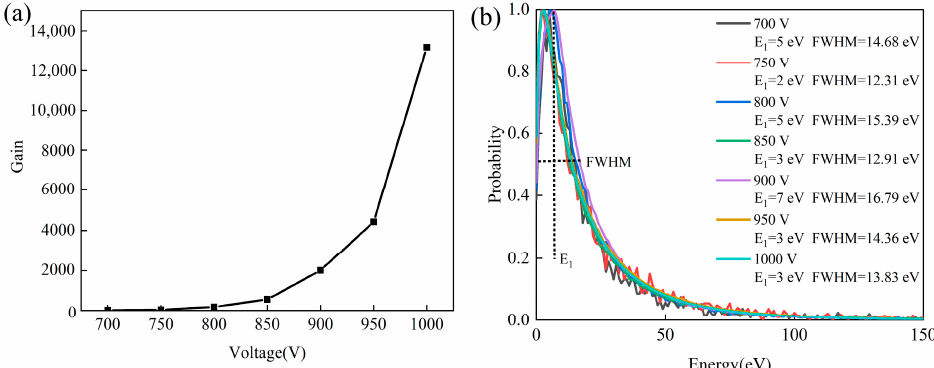
Figure 12. Effect of the applied voltage on secondary electron multiplication ( L / D = 39, θ = 6 o , l 2 = 6 µ m): ( a ) Gain; ( b ) The most probable exit energy distribution.